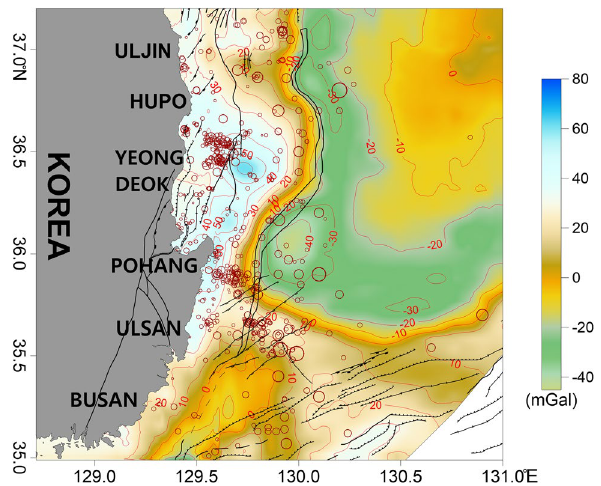
Figure 4. Free-air gravity anomaly map of the study area. Contour intervals are 10 mGal. The major geologic structures and symbols of the earthquakes are the same as those in Fig. 2. This figure was generated using the Surfer software (https:// www. golde nsoft ware. com/).